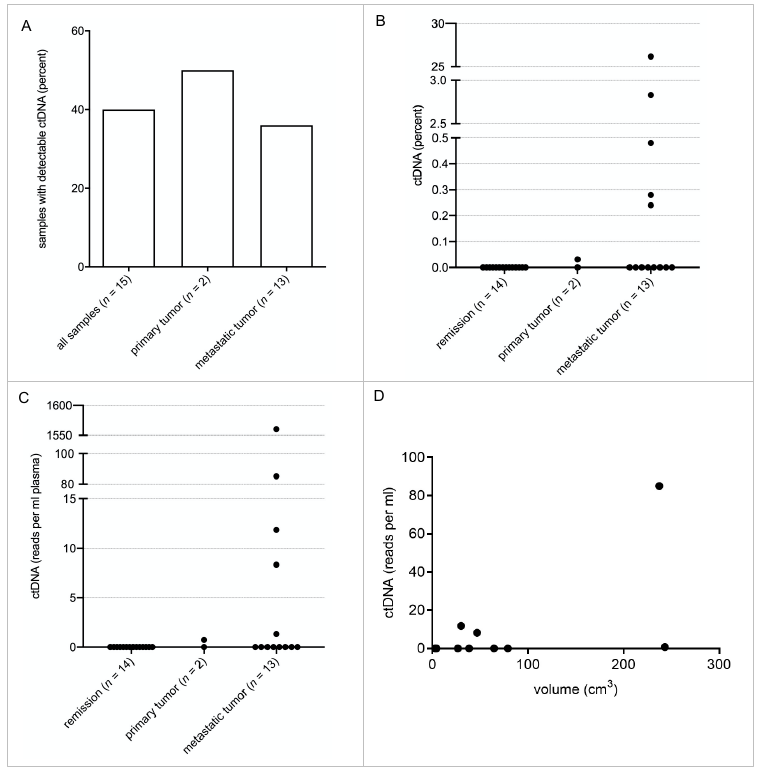
Figure 2. Quantification of ctDNA in SS patient plasma samples. A total of 29 plasma samples from 15 patients collected over 3 years of treatment and follow-ups were analyzed with the breakpoint panel derived from the data obtained with the subtype-specific panel. ( A ). ctDNA was detected in 40% of the total “active” samples (6 out of 15). One of two samples from primary tumor patients was positive, as well as 38.5% of those who had metastasis (5 out of 13 patients). None of the samples from patients in remission contained detectable ctDNA. ( B ). Depicted are the relative amounts of ctDNA for each plasma sample calculated as a fraction of cfDNA. ( C ). Depicted are the absolute amounts of ctDNA in reads/mL plasma for each plasma sample. ( D ). The absolute amounts of ctDNA are correlated to the detectable tumor volume. A correlation analysis shows a correlation coefficient of 0.55 with a p -value of 0.0276 (CN 95%) R 2 coefficient of 0.563.